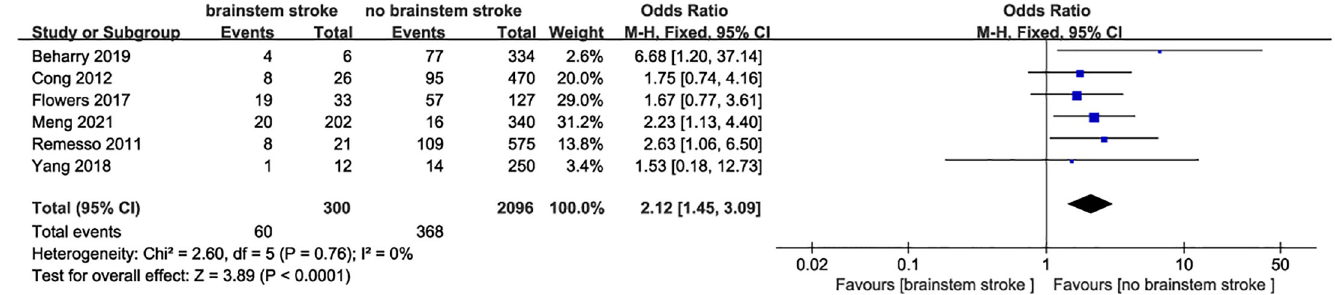
Fig 6. Forest plot for the relationship between brainstem stroke and dysphagia after